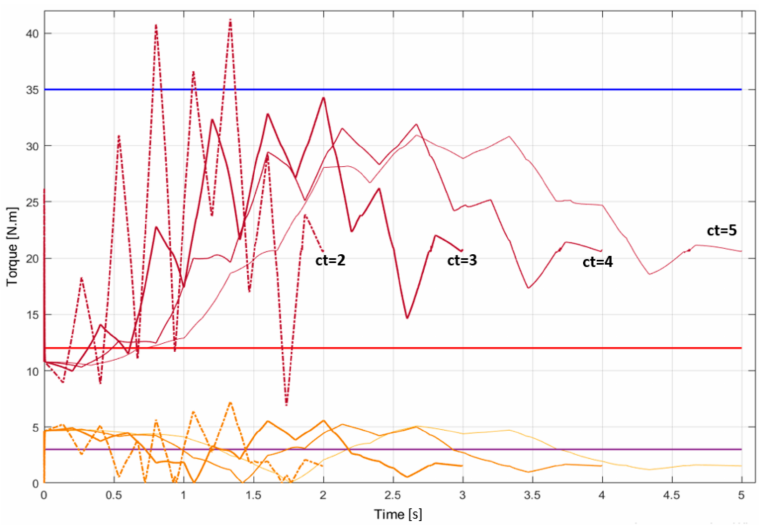
Figure 17. Variation of joint torques—original path—for di ff erent cycles.